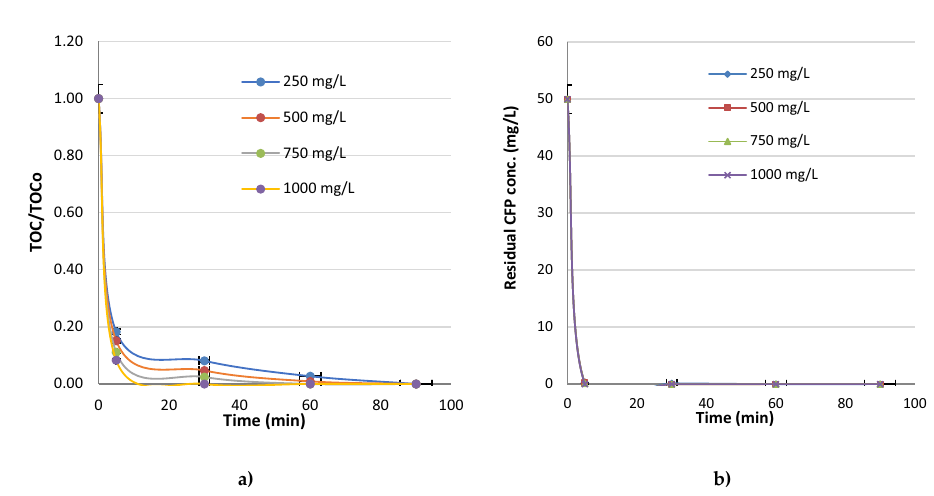
Figure 4. Effect of potassium chloride with Sn:Sb:Ni: 500:8:1 anode ( a ) TOC/TOC o and ( b ) Residual CFP conc. (pH 8 and I: 50 mA cm −2